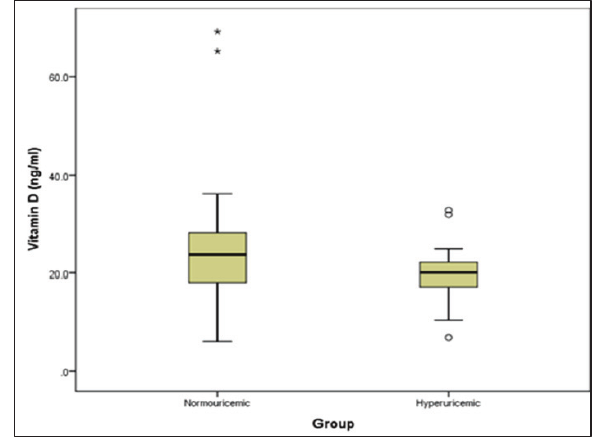
Fig-1: Boxplot presenting distribution for vitamin D levels amongst both group of study subjects.